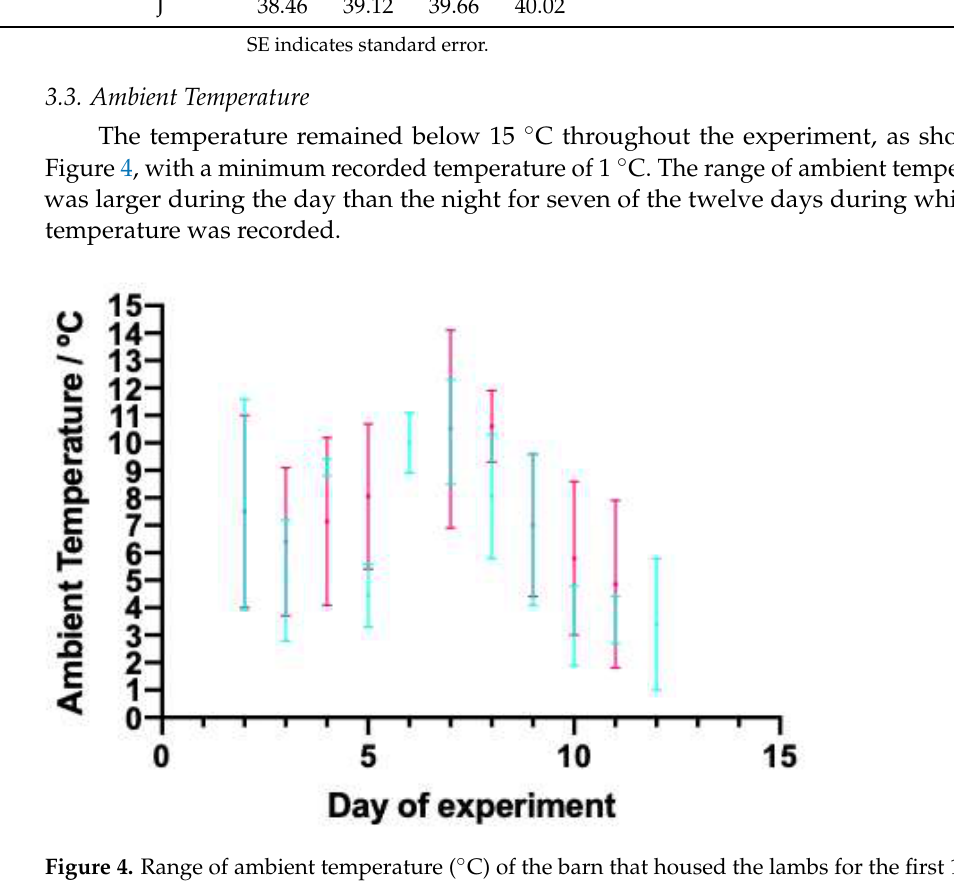
Figure 4. Range of ambient temperature (°C) of the barn that housed the lambs for the first 12 days of the study. Blue lines show the minimum and maximum temperatures reached between 20:00 and 08:00, and pink lines show the minimum and maximum temperatures reached between 08:00 and 20:00. By day 12 of the study, all lambs had moved out of this barn.